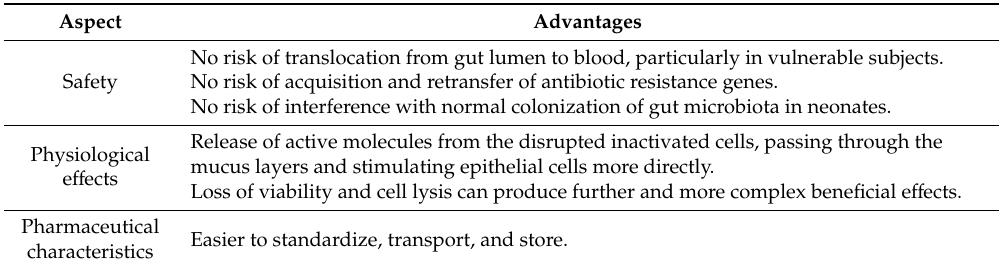
Table 1. Advantages of inactivated bacteria and / or purified compounds in comparison with live probiotics.